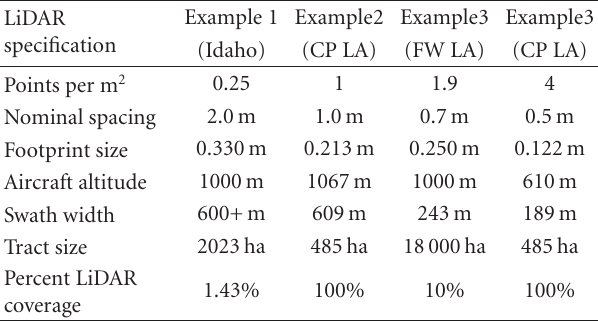
Table 1: LiDAR specifications for sample single-tree inventory projects in conifers and mixed hardwoods in Idaho and Coastal Plain (CP) and Flatwoods (FW) areas of Louisiana